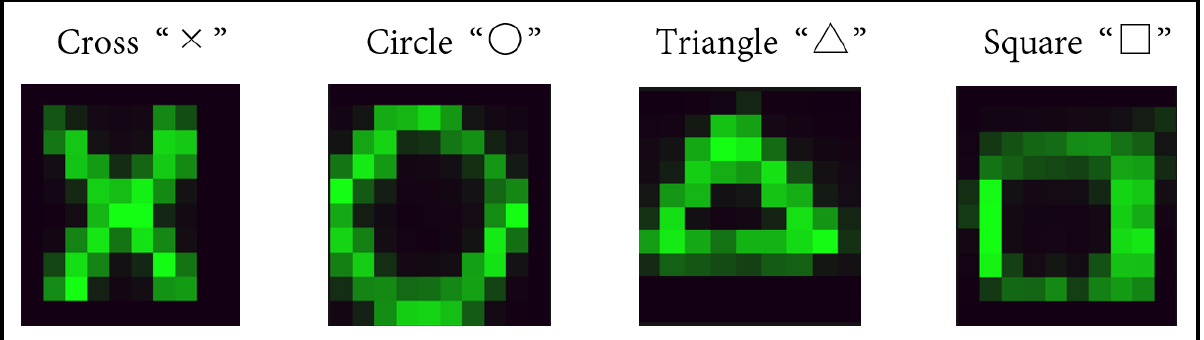
Figure 12. Output of sensor for each line angle.